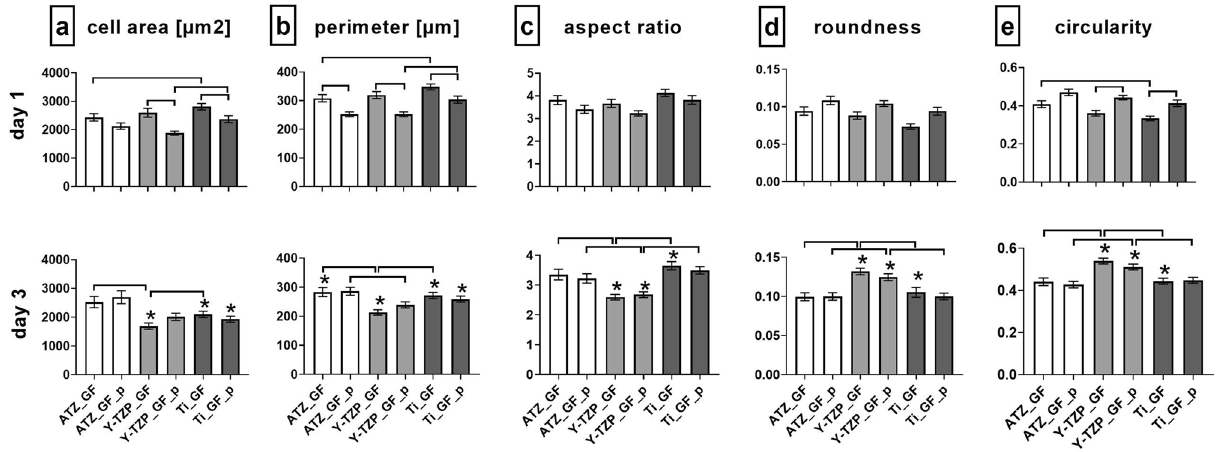
Figure 11. Quantitative morphometric analysis of fibroblast morphology after 1 and 3 days of culture on functionalized and control surfaces. Since the cells had reached confluence at day 7, no morphometric analysis was possible at day 7. Data are presented as mean values (145 < n < 300) ± SEM. Statistically significant differences ( p < 0.05, Dunn´s HSD test) were marked with brackets above the corresponding bars. “*” marks statistically significant differences between day 1 and